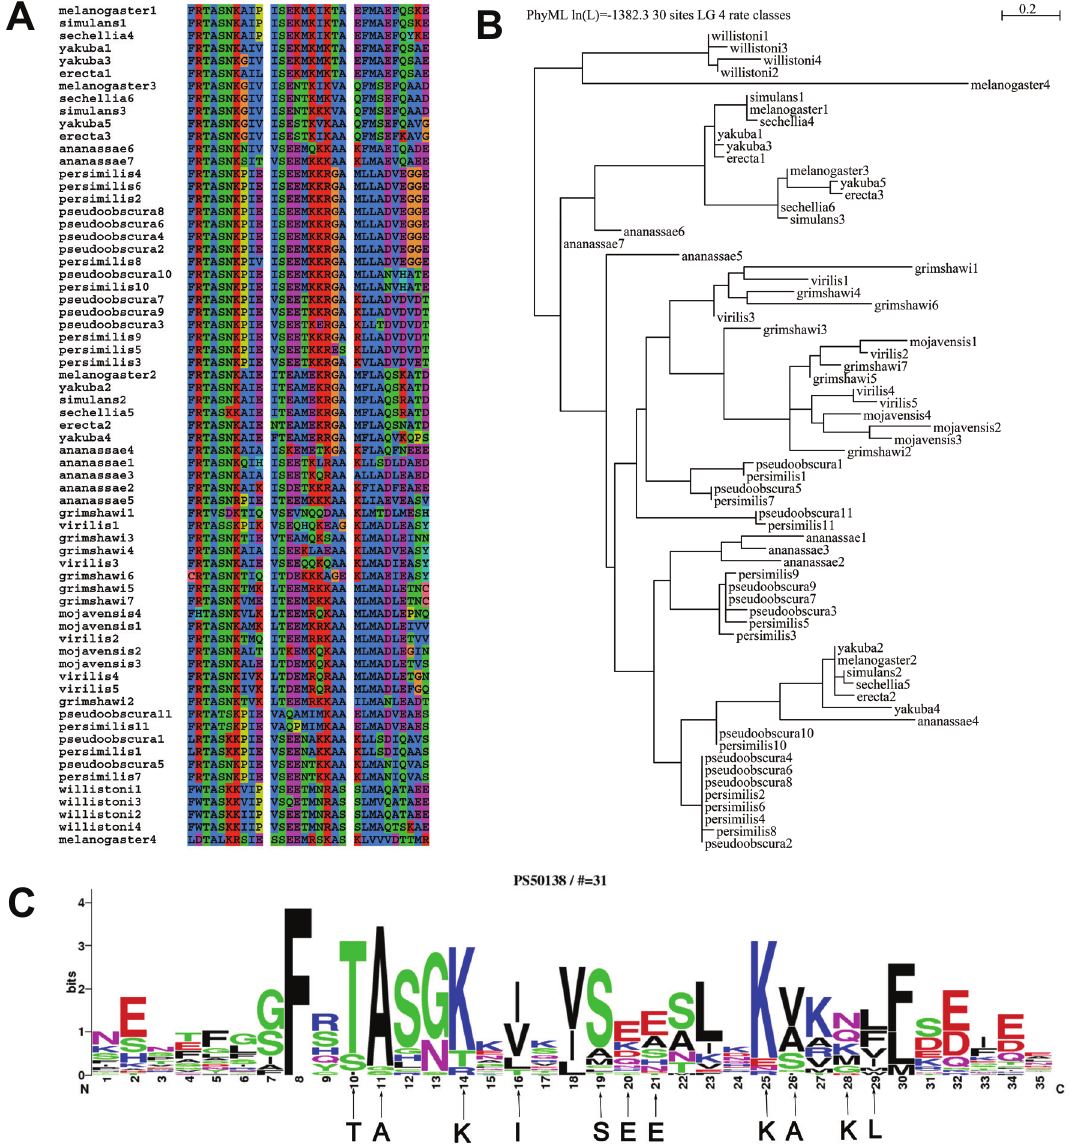
Figure 2. New BRC repeat identified by FRAGAL in Drosophila melanogaster . ( a ) The multiple alignment for this new sequence (634–664:LDTALKRSIESSEEMRSKASKLVVVDTTMR) (using ClustalW) highlighted as melanogaster4 and other sequences compared previously in 17 . This putative sequence is more closely related to the sequences in D. willistoni than other members of the genus. ( b ) The phylogenetic tree (using PHYML) gives a graphical representation of the relation of the various repeats in the Drosophila genus, corroborating the closer relation of the new BRC repeat to D. willistoni. ( c ) Alignment of the new BRC repeat to the sequence logo of the Prosite BRCA2 repeat profile PS50138. FRAGAL (Figure 2) has been identified. Pruning out matches which do not have a corresponding conserved sequence in hBR- CA2 helps us to select fragment 61 in dmBRCA2 as a new BRC repeat 7,14 , and fragment 91 in dmBRCA2 as the putative threonine site for phosphorylation by checkpoint kinase Chk1 and Chk2 10 . It must be noted that the sites identified remain putative until verified by experimental data, in spite of the low E-values